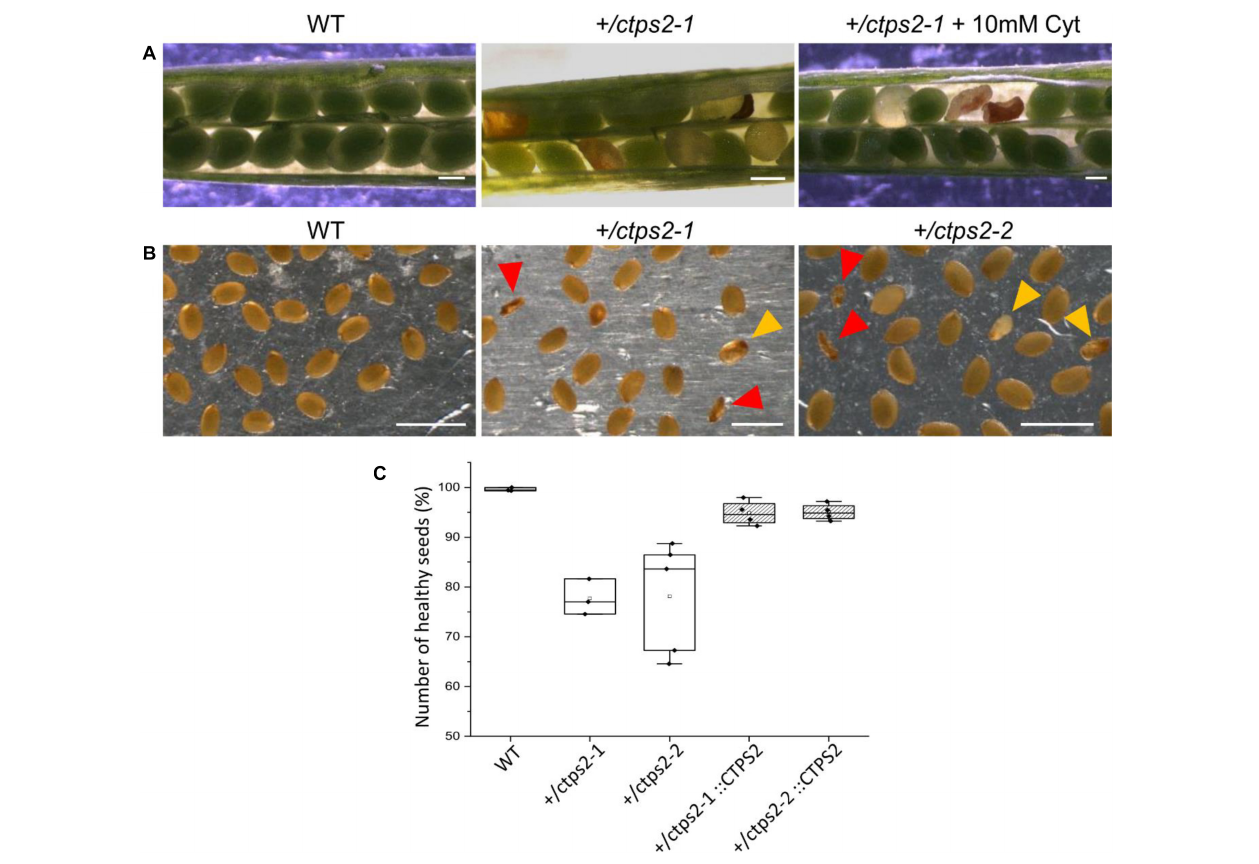
FIGURE 2 | Identification of homozygous ctps2 seeds. Siliques were opened 8–10 days after fertilization (DAF) from wild-type (WT) and +/ctps2-1 plants. (A) irrigation of +/ctps2-1 plants with 10 mM cytidine cannot rescue the aborted seed phenotype. Twelve DAF siliques were harvested and desiccated at room temperature, and seeds were collected using light microscopy. (B) red arrowheads point to collapsed seeds, while golden arrowheads indicate colorless seeds with nearly normal size, containing presumably embryos arrested early in development. Counting of seeds for WT, +/ctps2 , and complemented +/ctps2 plants. Scale bar = 0.25 mm in (A) and 1 mm in (B) . n = 3 for WT and +ctps2-1 with a total of 38 and 40 siliques, respectively; n = 4 for +/ctps2-1 ::CTPS2 and +/ctps2-2 ::CTPS2 with a total of 38 and 36 siliques, respectively; n = 5 for +/ctps2-2 with 52 siliques in (C)